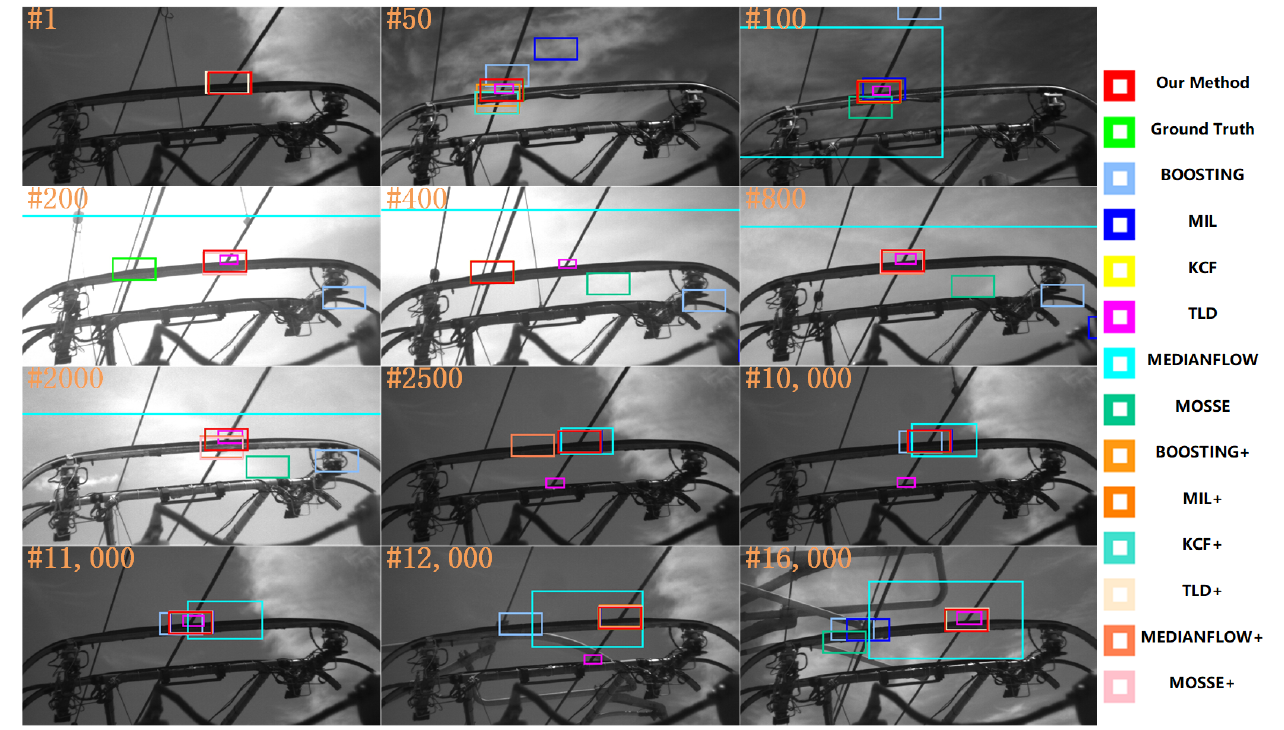
Figure 7. Illustration of tracking results in long-term datasets. Table 1. The speed (frames per second) and accuracy of each tracking